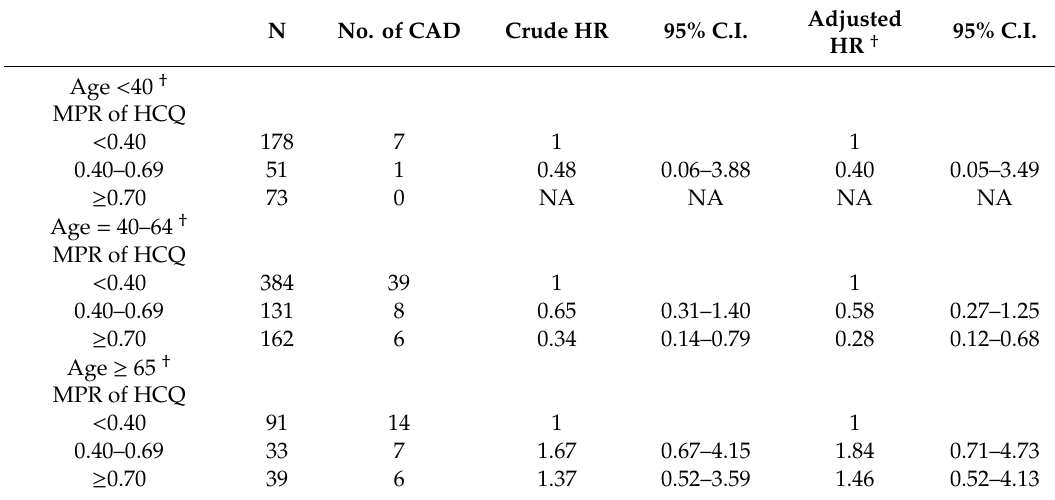
Table 3. The evaluation of CAD attack in patients with SS by different age and gender. N No. of CAD Crude HR 95%